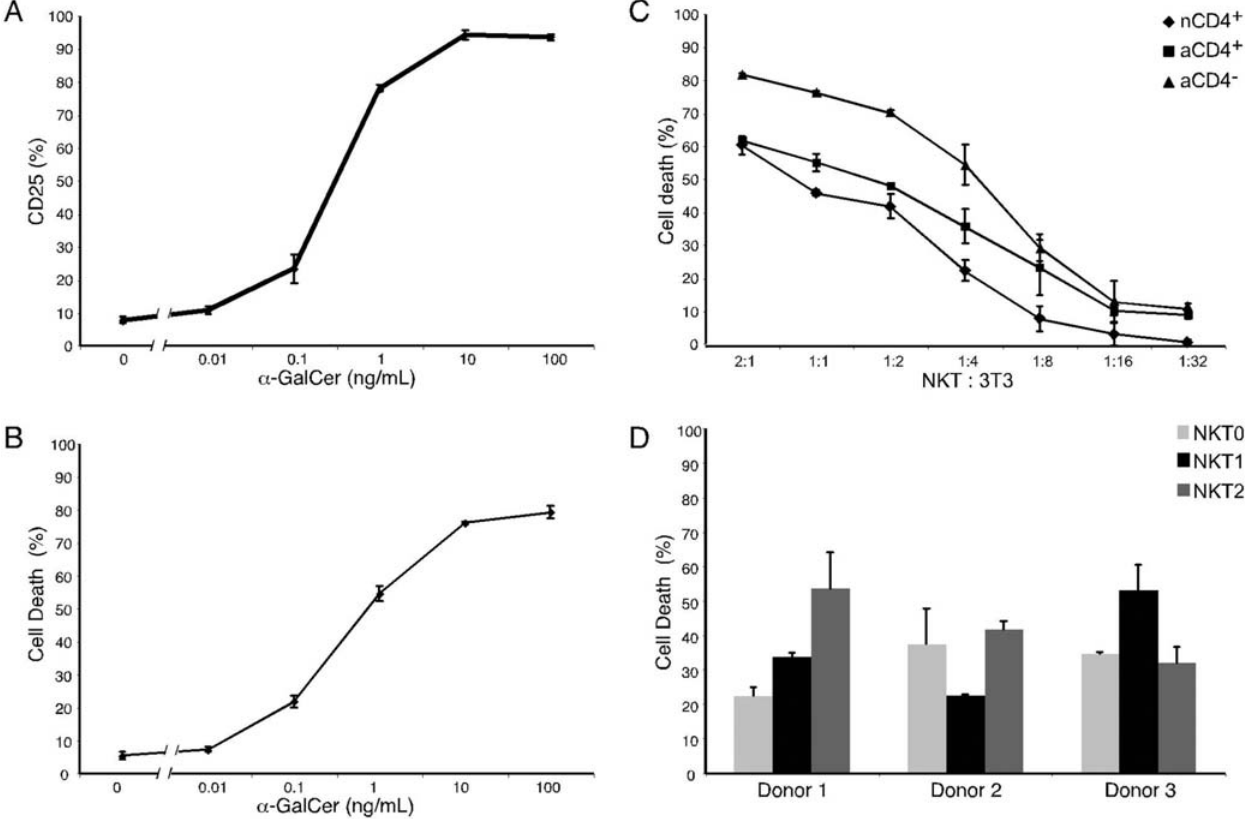
Figure 5. Cytotoxic capability of NKT cell subsets. Experiments were performed in triplicate per donor; standard deviation is depicted. For A, B, C, and D, one representative donor out of three independent experiments is shown. (A) NKT cells were added at an Effector:Target (NKT cell: 3T3 cell) ratio of 1:1 to adherent 3T3 cells in the presence of different a -GalCer concentrations. After 18–20 hours, NKT cells were collected and stained with anti-CD25 (unlabelled followed by goat anti-mouse APC) to determine activation. (B) As in A, NKT cells at an NKT:3T3 of 1:1 were activated in the presence of varying concentrations of a -GalCer. After 18–20 hours, cells were collected by trypsinization to remove any 3T3 cells that were still adherent and target 3T3 cells were stained with propidium iodide to determine their viability. (C) a -GalCer was added at a concentration of 100 ng/ml to adherent 3T3 cells. NKT cell subsets were then added at different NKT:3T3 ratios. Viability of 3T3 cells after an 18–20 hour incubation period was determined as in 5B. (D) Polarized nCD4 + NKT cells were generated as in Figure 2. The cytotoxic capacity of these NKT0, NKT1, and NKT2 lines was assayed as in Figure 5C. One NKT:3T3 ratio for each donor is shown.